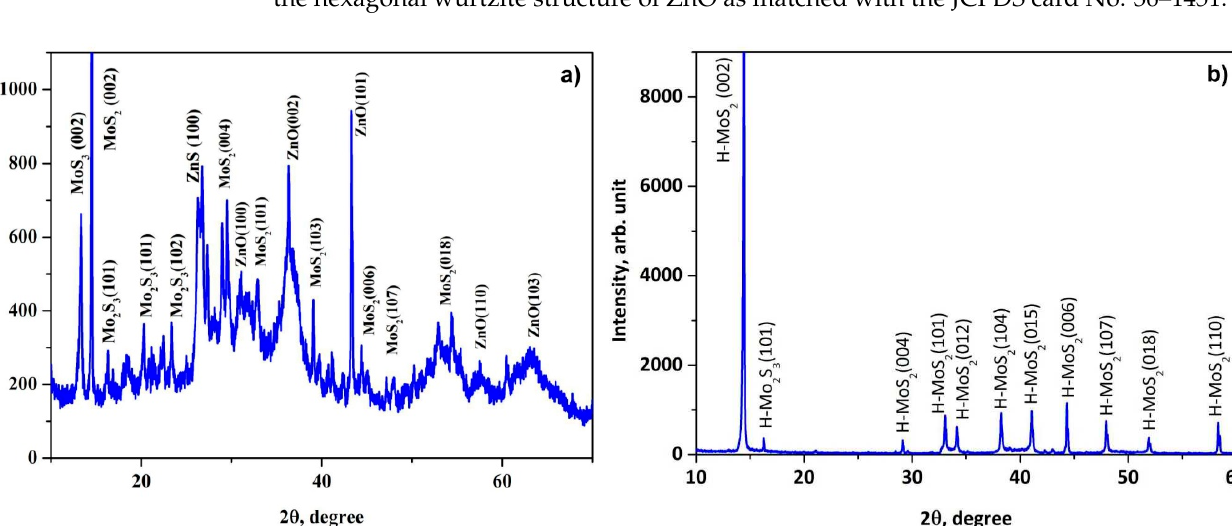
Figure 2. X-ray diffraction (XRD) patterns of the prepared MoS 2 @ZnO nanoheterostructures ( a ) and initial nanostructured MoS 2 ( b ).